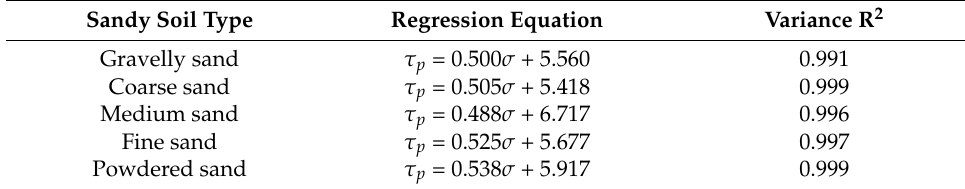
Table 3. Regression equation of shear strength and normal stress of interface.